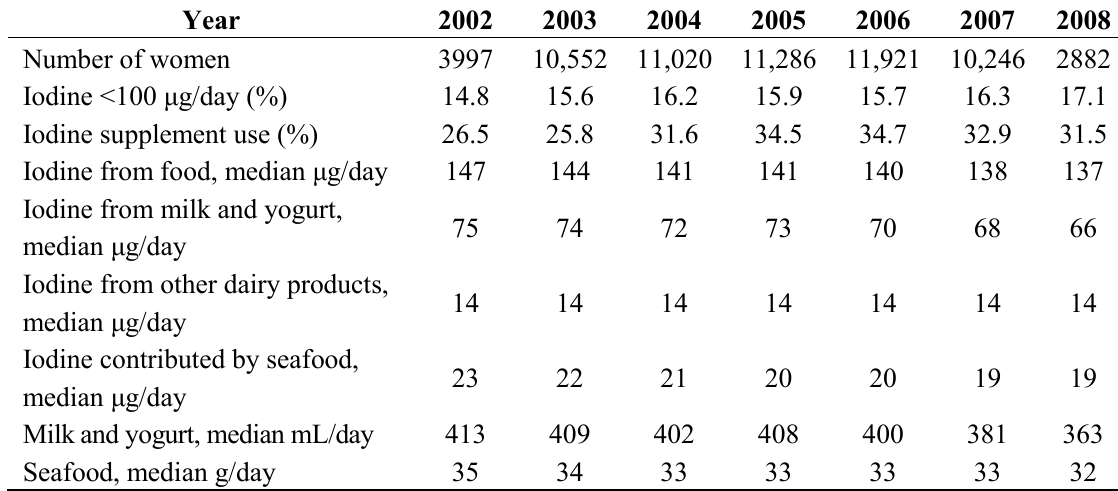
Table 4. Intake of iodine and selected iodine sources by year of delivery, n = 61,904 pregnant women.